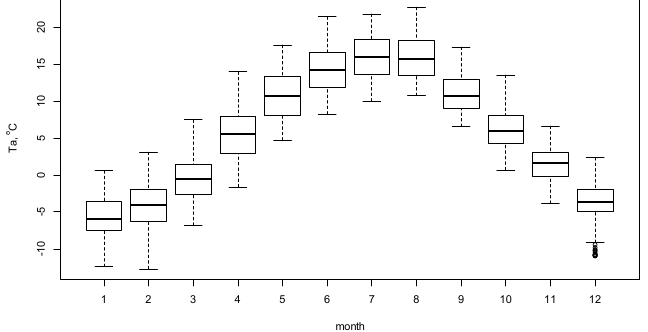
Figure 9. Outside temperature (Ta) in Banska Nizna: average temperature in each day hour in each month in 2000-2019.